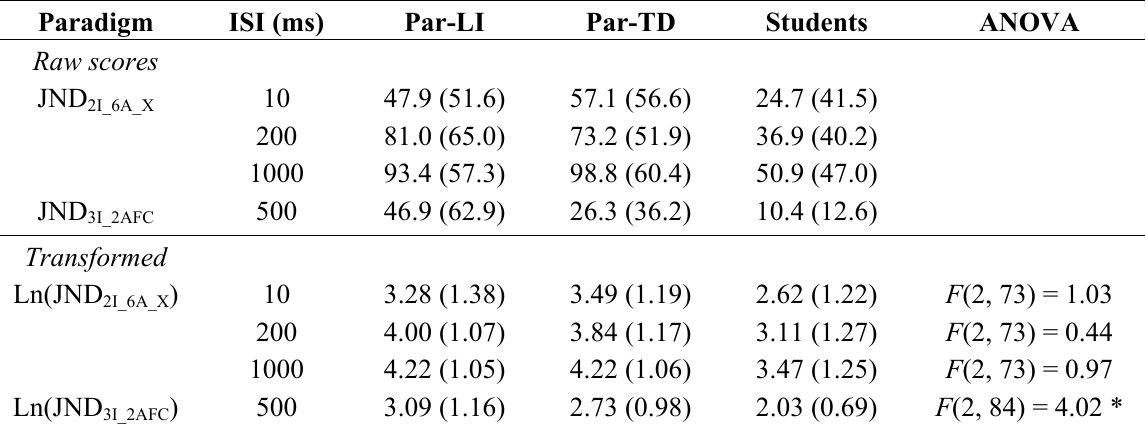
Table 1. Summary of raw and natural log (ln) transformed Just Noticeable Differences (JNDs) (means, standard deviations) as estimated from the 3I_2AFC and 2I_6A_X paradigms. Results from one-way ANOVAs comparing the means for the transformed data are reported. * p < 0.05 indicates a significant group